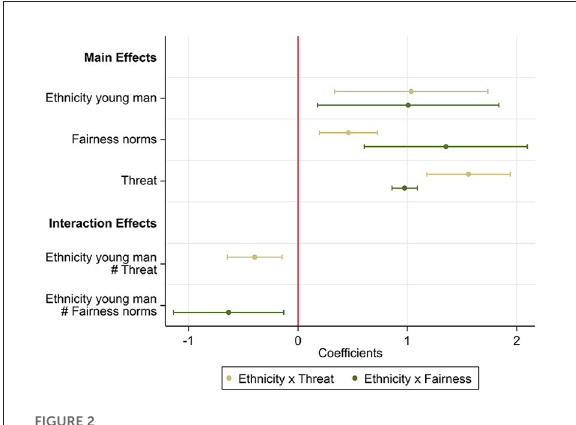
FIGURE2 Factorial survey treatments’-interaction-effects on the likelihood of the old white man calling the police, multilevel mixed-effects linear regressions.